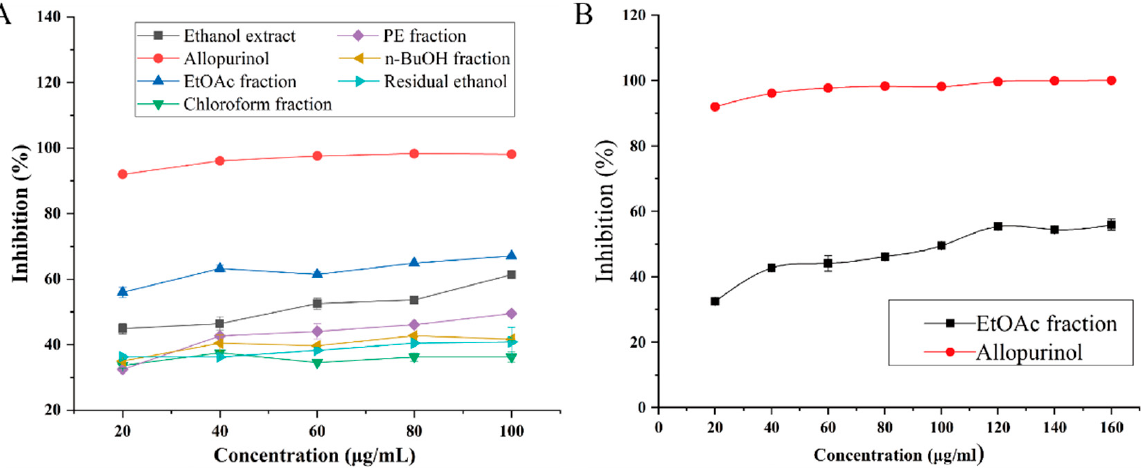
Figure 2. ( A ) XO-inhibitory activity of Smilax china L. extracts. ( B ) Inhibitory effects of the EtOAc fraction and allopurinol on XO activity.